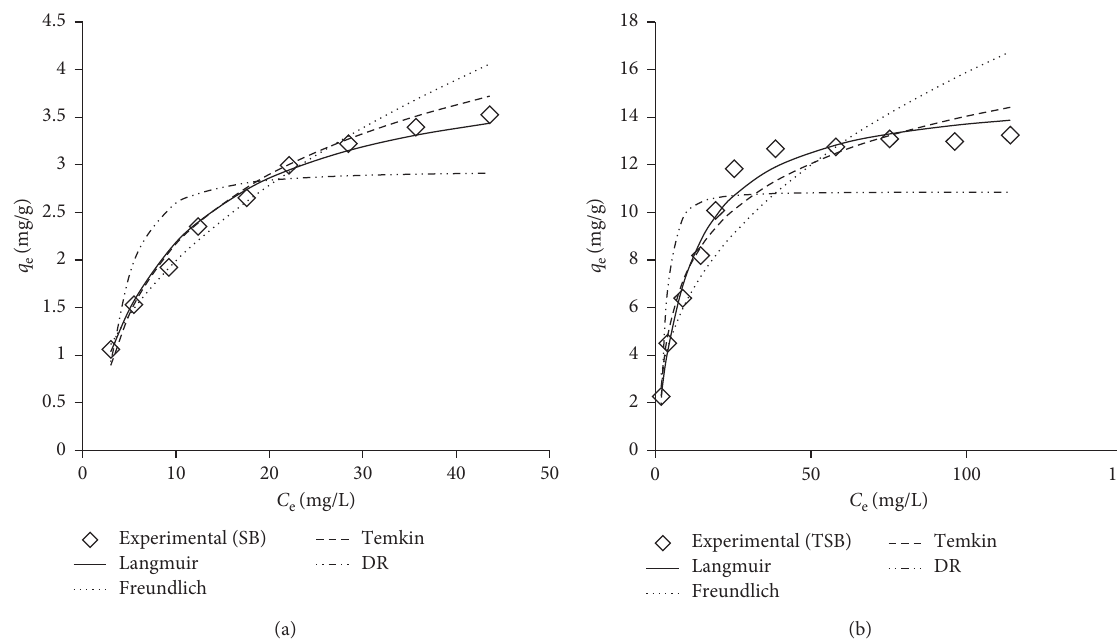
Figure 8: Nonlinear equilibrium plots for Cu(II) biosorption by (a) SB and (b) TSB.